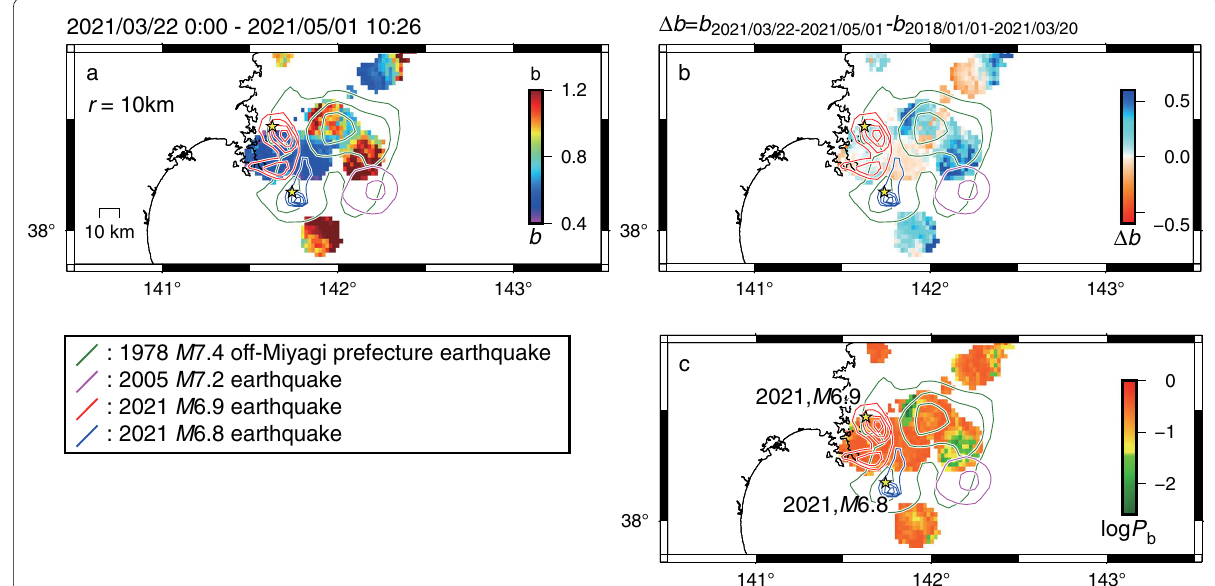
Fig. 4 b -value analysis for the period between the M 6.9 and M 6.8 earthquakes. a Map of b values obtained from the seismicity for the period from March 22, at 0:00 to May 1, at 10:26 ( b 2021/03/22–2021/05/01 ), where we do not consider the period (March 20, at 18:10–March 21, 23:59) from immediately after the M 6.9 March 20 earthquake to the end of March 21, avoiding the time period with large temporal variation in b . Other symbols are the same as in Fig. 1. b Δ b ( b 2021/03/22–2021/05/01 b 2018/01/01–2021/03/20 ), subtraction of the b value in the bottom panel in Fig. 2a ( b 2018/01/01– = − 2021/03/20 ), from the b value in a ( b 2021/03/22–2021/05/01 ). c log P b , the logarithm of the probability that b 2018/01/01–2021/03/20 and b 2021/03/22–2021/05/01 are not